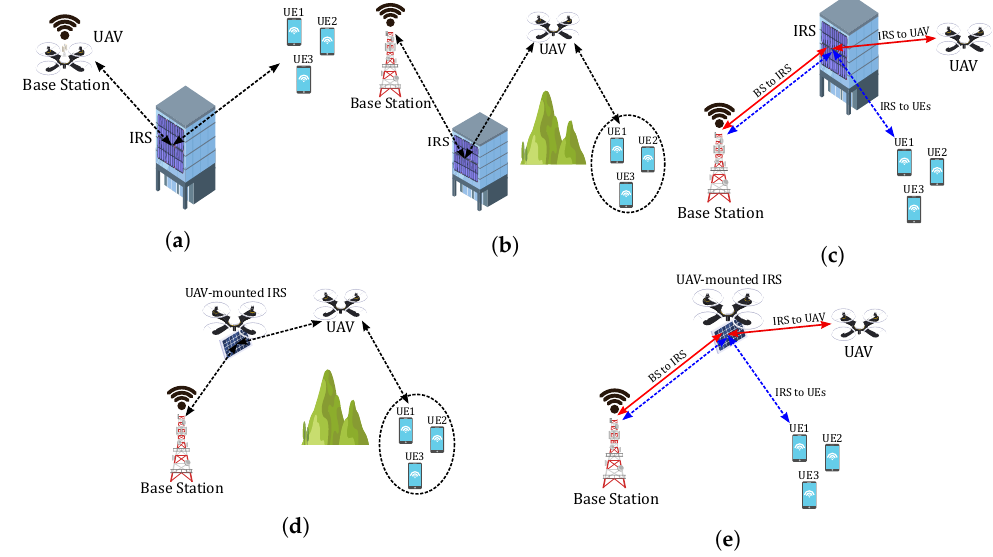
Figure 2. Five representative scenarios of IRS-assisted UAV